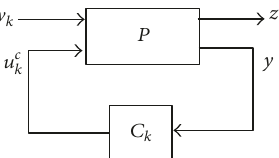
Figure 3: Block diagram of the control system for the synthesis of the semiactive control law 𝐶 𝑘